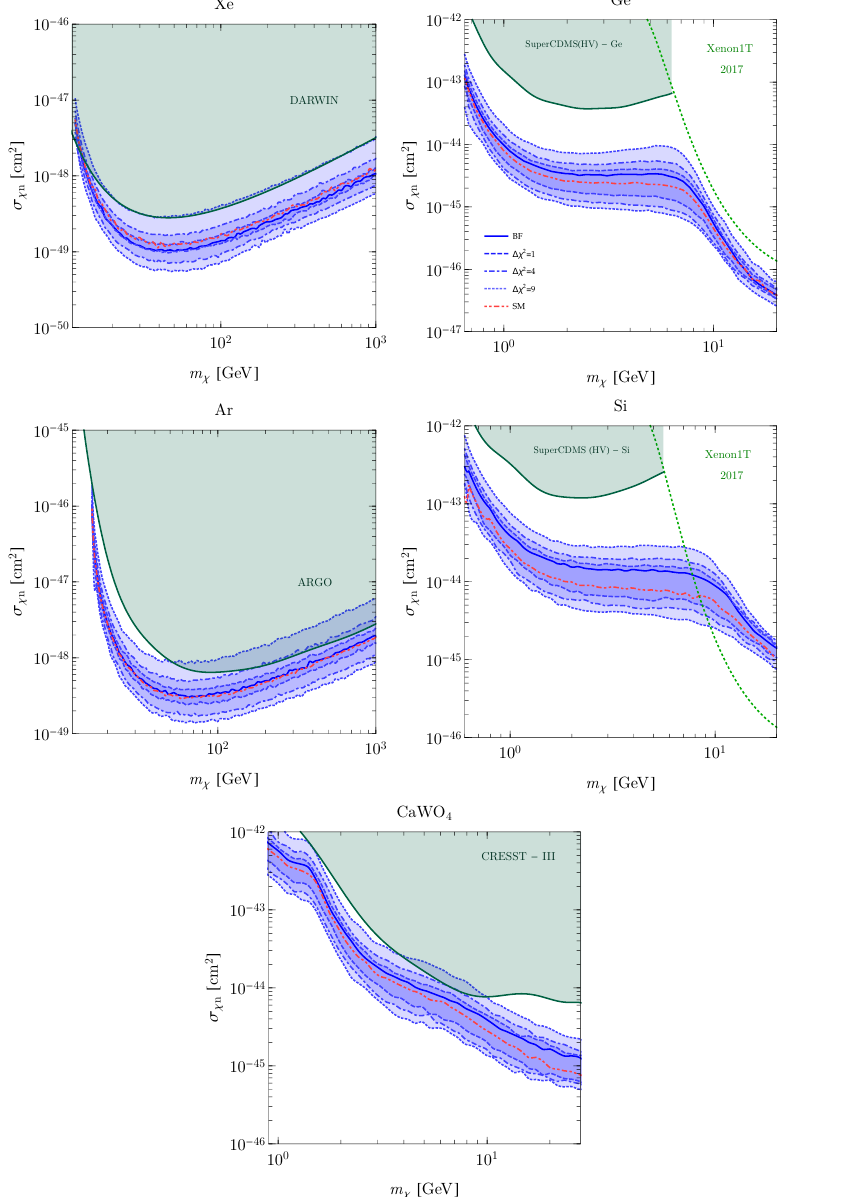
Figure 4 . Impact of NC-NSI couplings with up quarks on the discovery limits of (cid:12)ve di(cid:11)er- ent proposed experiments, DARWIN (top-left panel) [7], SuperCDMS - HV (Ge { top-right, Si { medium-right panels) [8], ARGO (medium-left panel) [9] and CRESST phase III (bottom panel) [6]. The red dashed line corresponds to the SM prediction while the blue full line to the best (cid:12)t NSI and oscillation parameters of the analysis of oscillation+COHERENT data. The shaded regions bordered by dashed, dot-dashed, and dotted lines correspond to predictions with NSI and oscilla- tion parameters within (cid:1) (cid:31) 2 (cid:20) 1, 4, 9, respectively. In each panel we show in green, for OSC+COH comparison, the sensitivity region as quoted by each of these experiments in the given references. For reference we also show by a green dashed line the region excluded by Xenon1T at 90% CL [87].